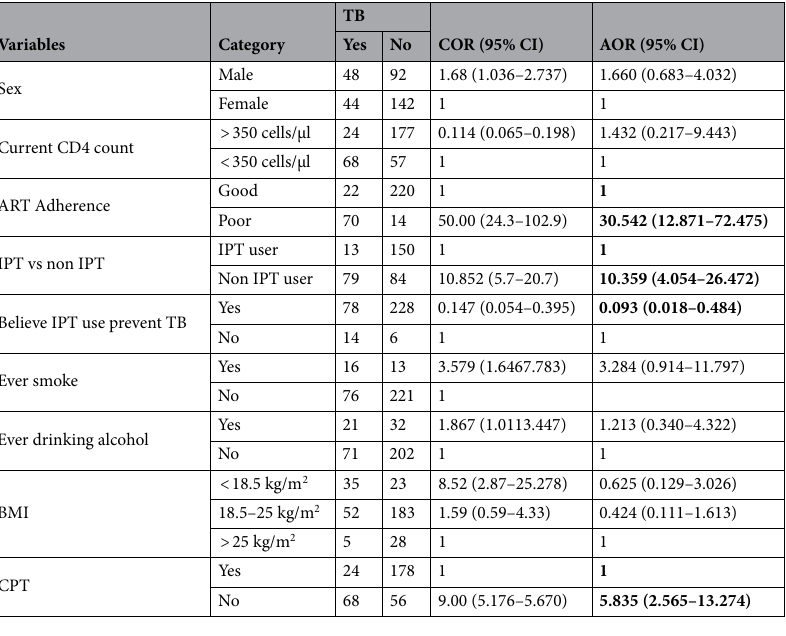
Table 6. Bivariable and multivariable logistic regression analysis of factors associated with TB among isoniazid and non-users IPT of PLWHIV Dessie city administrative 2021. Significant values are in